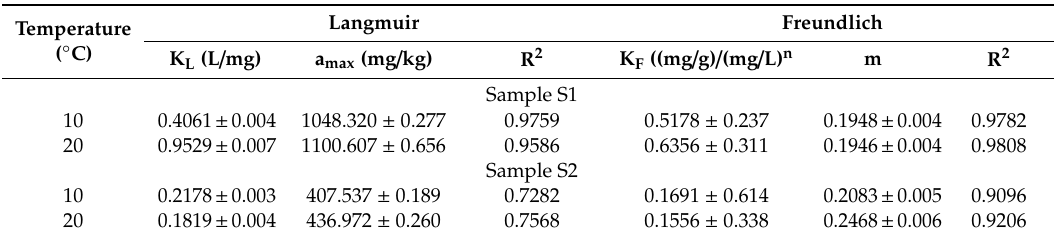
Table 3. Summary of Mn 2 + adsorption isotherm parameters for Mg-Al LDH (sample S1) and Mg-Al-Ni LDH (sample S2), at 10 and 20 ◦